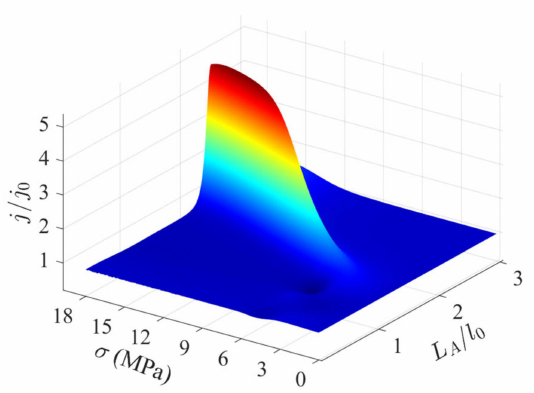
Figure 9. Variations in the output current at the PN junction with the variations in the height and position of the compressive-mode MIAPB when ∆ l = 1.0 l 0